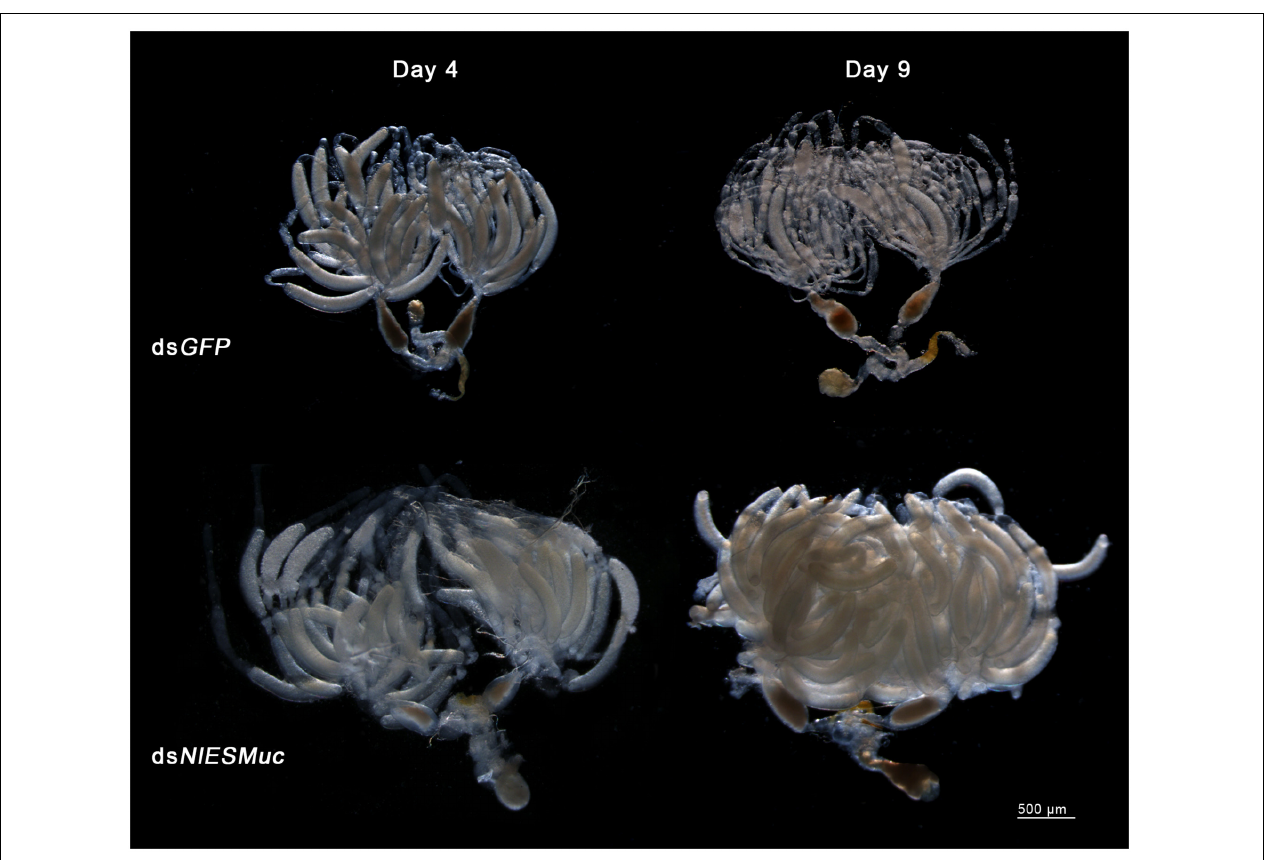
FIGURE 5 | The effect of RNAi on the ovaries in the dsGFP (control) and dsNlESMuc groups. There was no significant difference in oocyte morphology between the two groups. The ovaries in both groups contained considerable developed oocytes on day 4 after emergence. On day 9, ovaries in the dissected dsNlESMuc females ( n = 5) were full of developed oocytes, while most of the developed oocytes in the control group were oviposited.